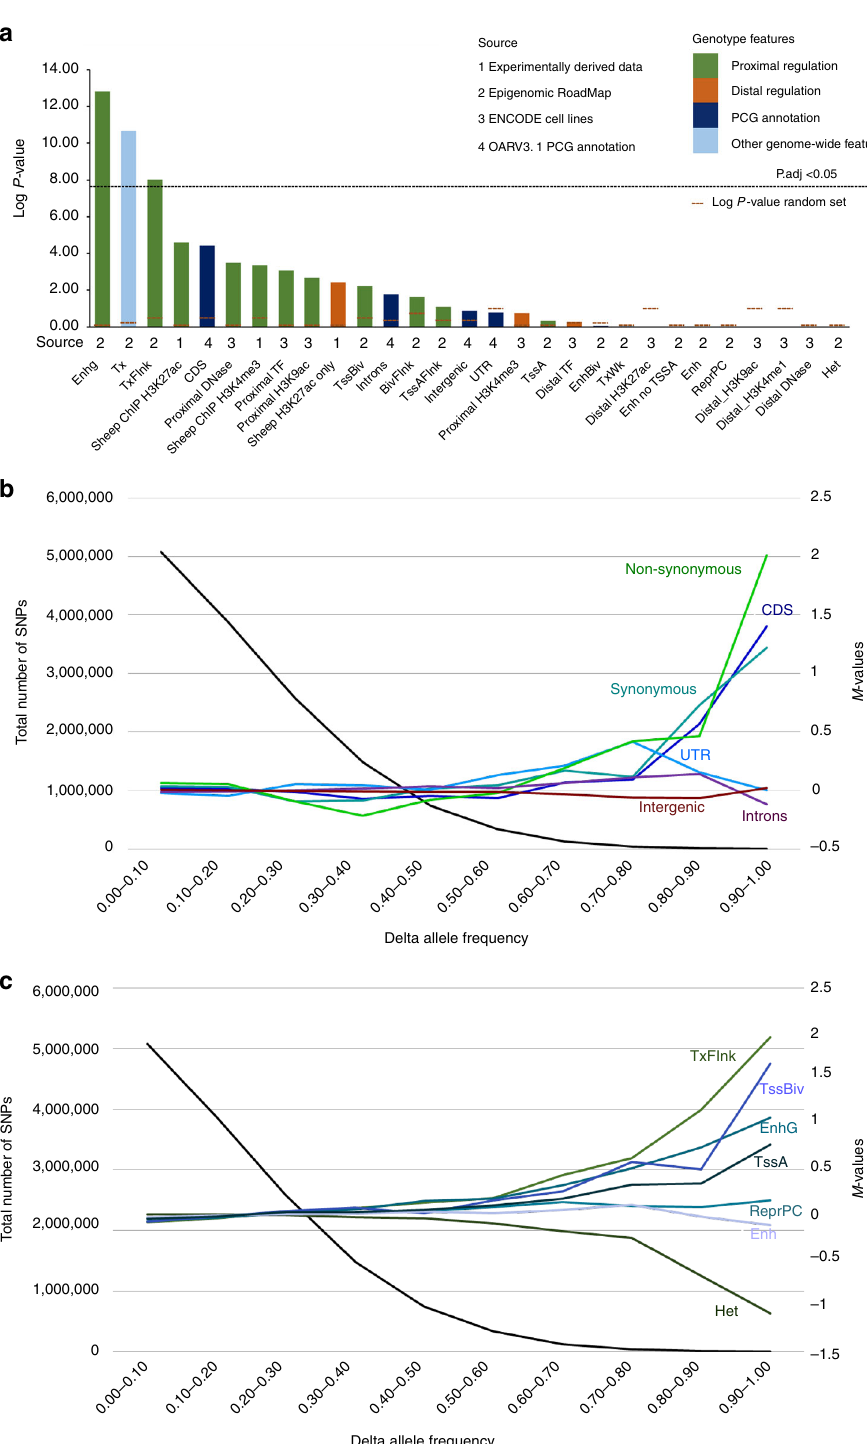
Fig. 4 Genomic feature enrichment in selection sweeps and differentiated sites. a Strength of enrichment for 29 genome features within 1420 sweep bins assessed by location overlap 49 . Genome features were derived from four different sources. The signi fi cance threshold from multiple testing is represented by the horizontal line. b Intersection of delta allele frequency ( Δ AF) with protein coding gene annotations from reference OARv3.1. The number of SNP in Δ AF bins is given at left, and the M -value (at right) was calculated by comparing the frequency of SNP in each genome feature and Δ AF bin with the corresponding frequency across all bins. c As for b using chromatin state annotations derived from the Roadmap dataset. Additional M -value results using predicted ENCODE marks are provided in Supplementary Fig.